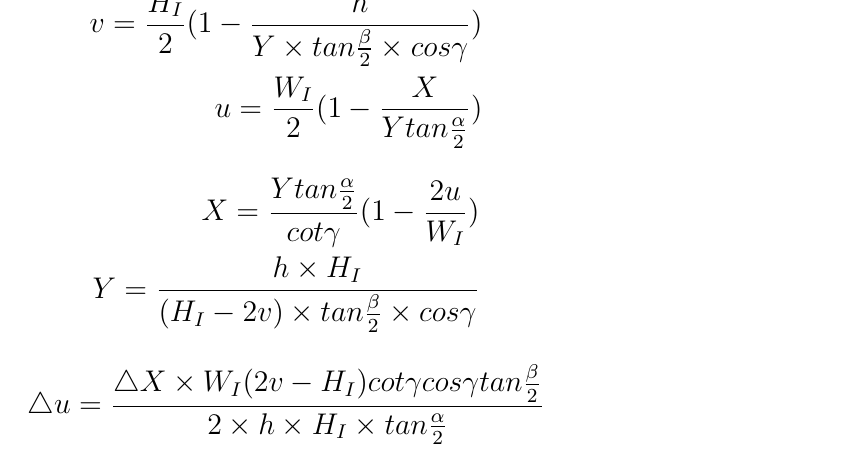
Figure 5. Imaging Model. ( a ) The W space. ( b ) The xy plane in the W space. ( c ) The yz plane in the W